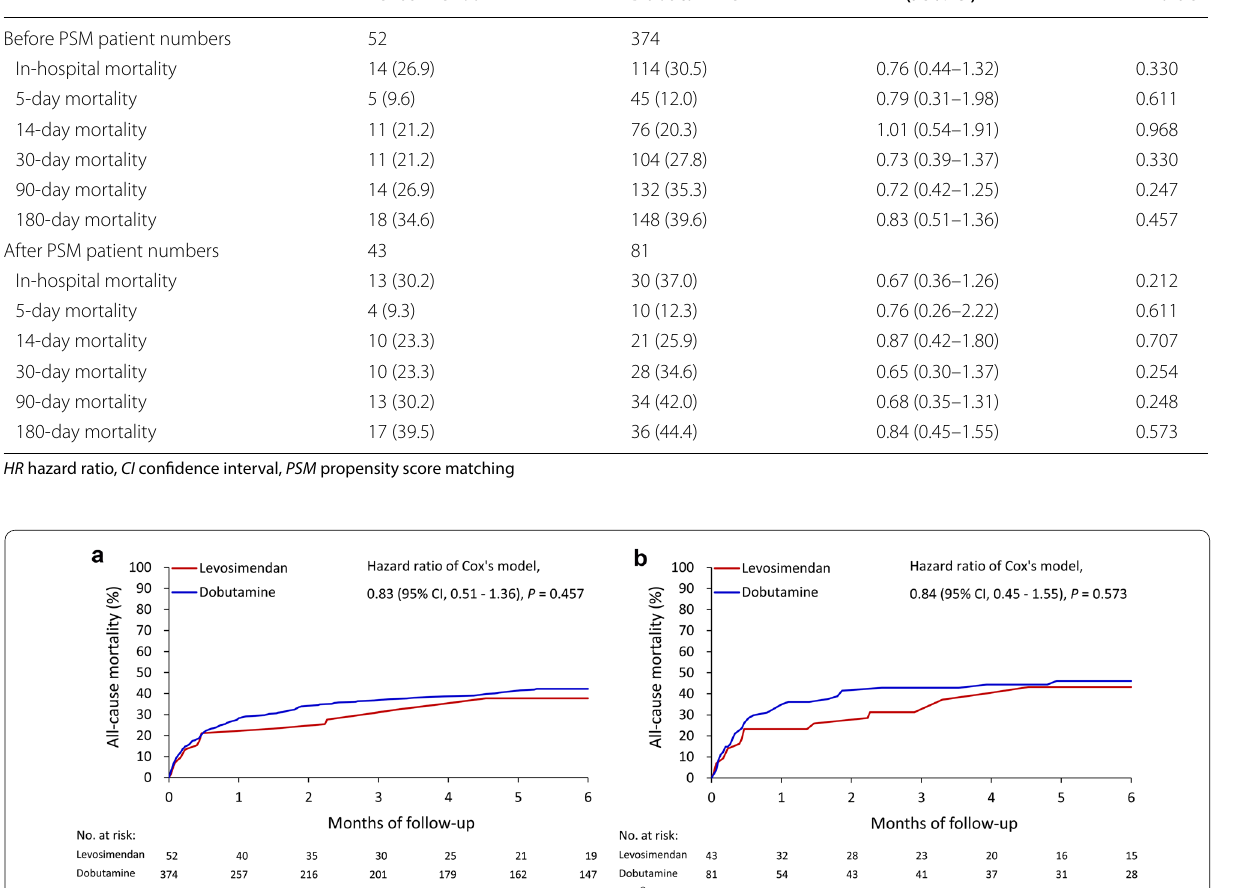
Fig. 3 All‑cause mortality rates of the patients with eGFR < 30 mL/min/1.73 m 2 or dialysis who received levosimendan versus dobutamine alone before ( a ) and after ( b ) propensity score